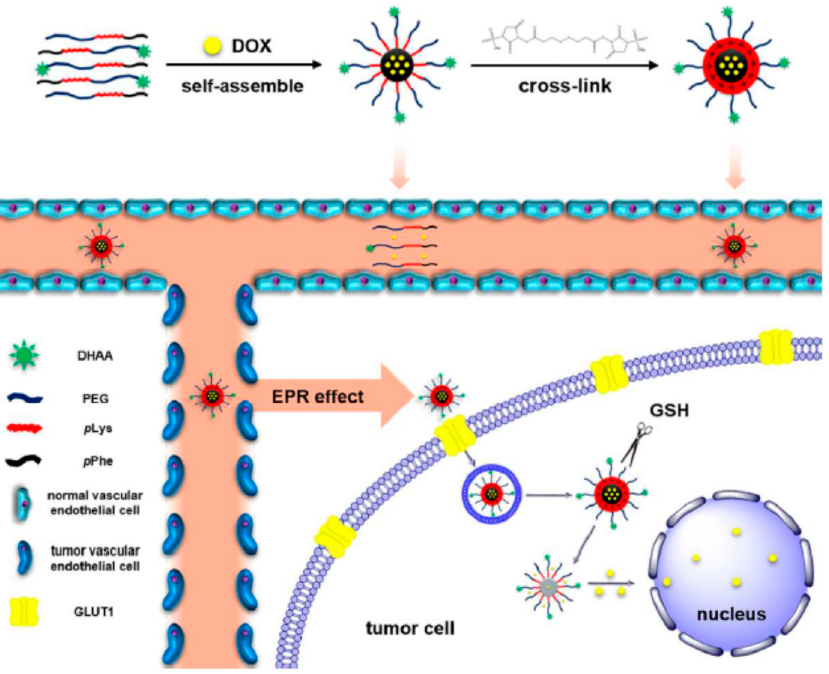
Figure 14. Stepwise synthesis, GLUT1-mediated endocytosis and GSH-triggered intracellular drug release of DPL(SS)P/DOX micelles [54].